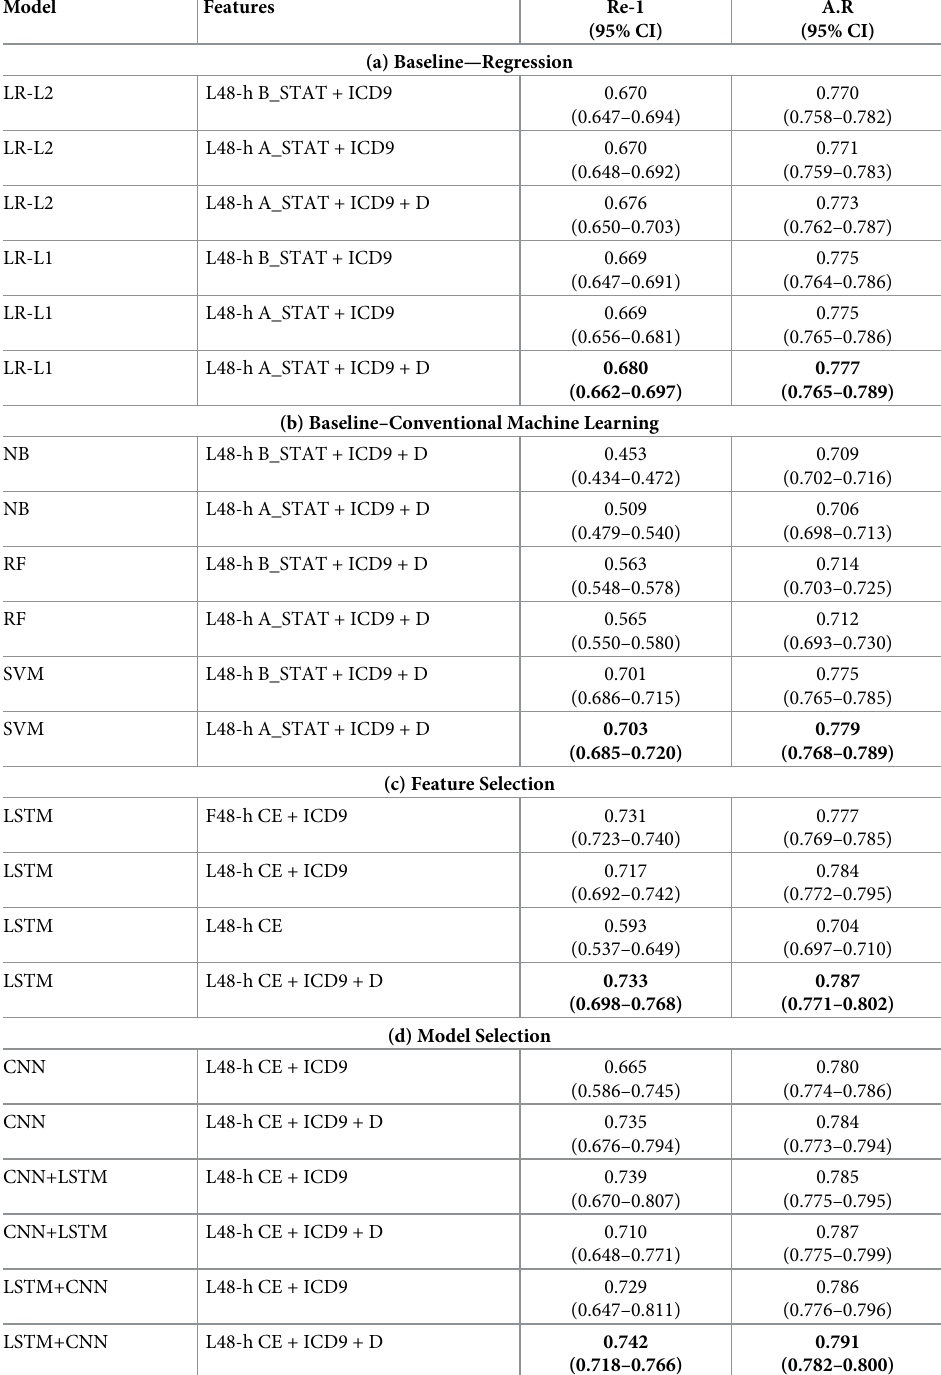
Table 3. Performance comparison of various machine learning models on different sets of